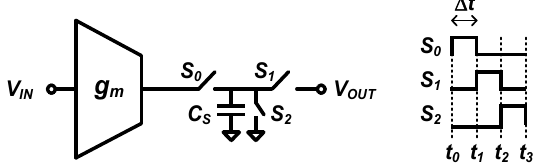
Figure 4. Unit configuration of the charge ‐ domain discrete ‐ time filter.